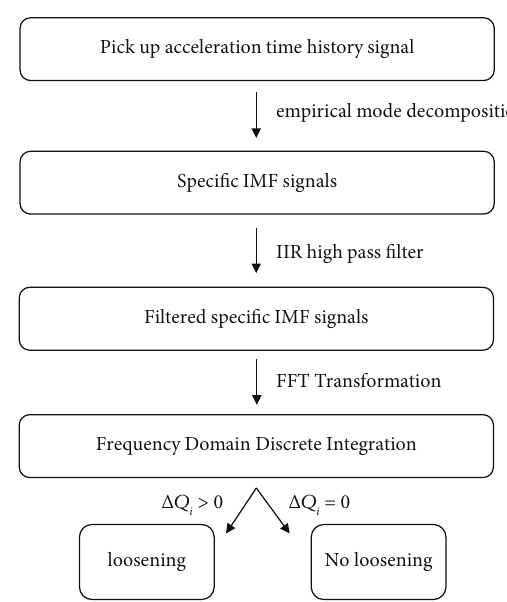
Figure 24: Loosening identification